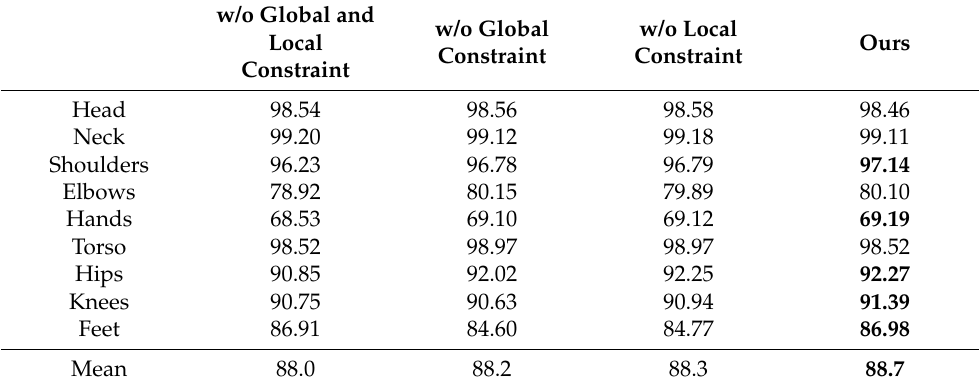
Table 3. The ablation results on the ITOP front-view